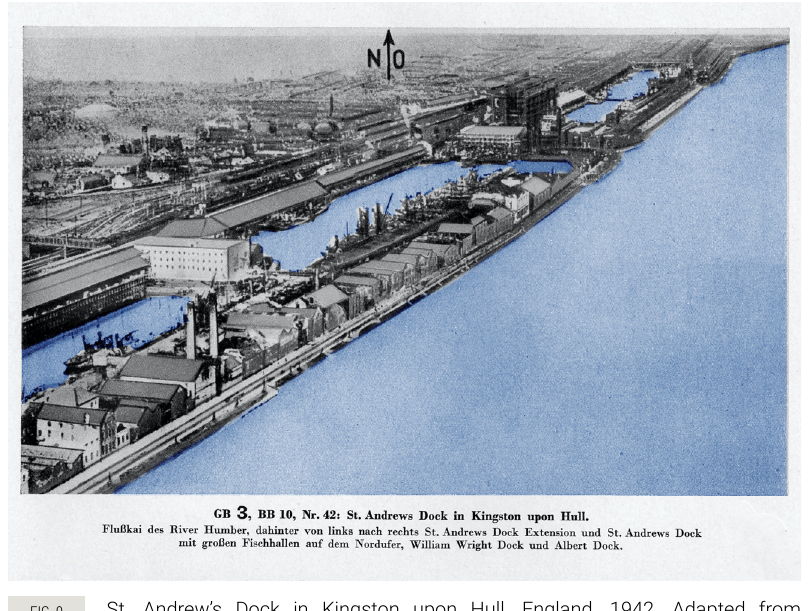
St. Andrew’s Dock in Kingston upon Hull, England, 1942. Adapted from Oberkommando der Wehrmacht, David Rumsey Map Collection, David Rumsey Map Center, Stanford Libraries.